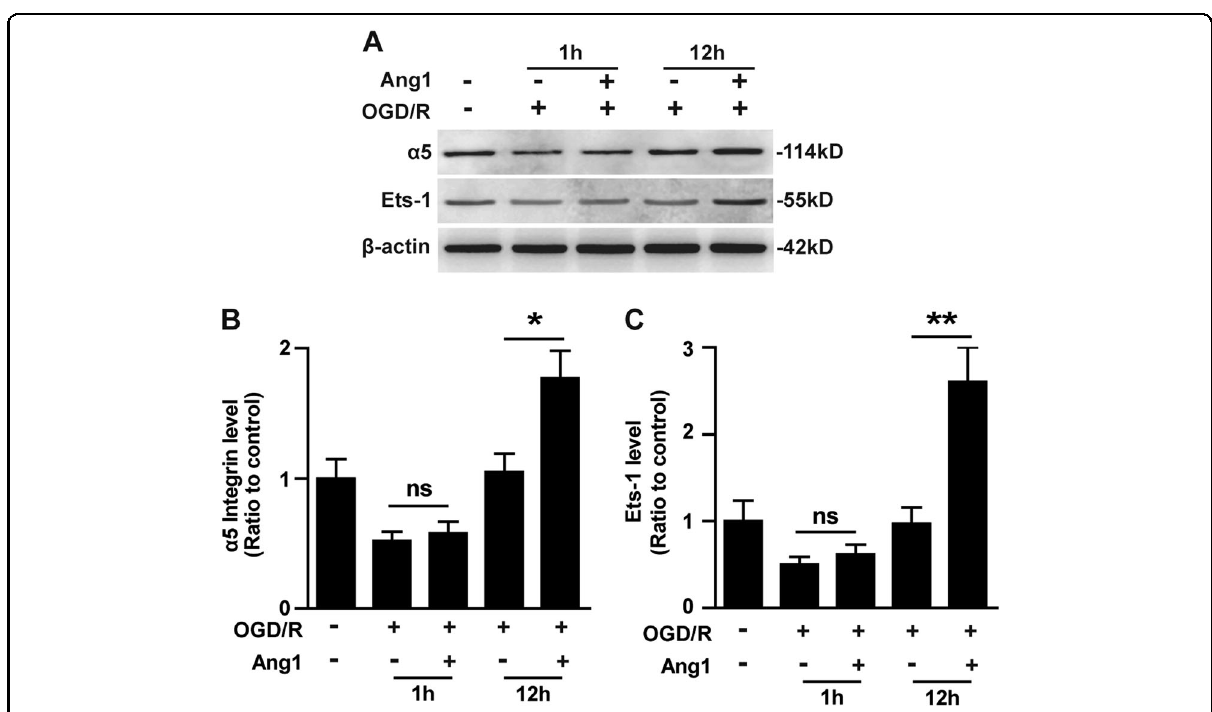
Fig. 5 Ang1 promotes BEC expression of integrin α 5 and Ets-1 under OGD/R conditions. BECs were subjected to 4 h of OGD and then stimulated or not with 100 ng/mL of Ang1 for the indicated periods under normoxia at 37 °C. a Cell lysates from BECs were analyzed to assess the levels of the indicated proteins by western blotting. b , c Protein levels of integrin α 5 ( b ) and Ets-1 ( c ) were quanti fi ed by densitometry and are presented as ratios to β -actin. The NO-OGD cells served as the control. Data represent the mean ± SEM and were analyzed by one-way ANOVA ( n = 3). Note that stimulation of OGD-treated BECs with Ang1 for 12 h signi fi cantly increased the expressions of both α 5 and Ets-1.* P < 0.05, ** P < 0.01;